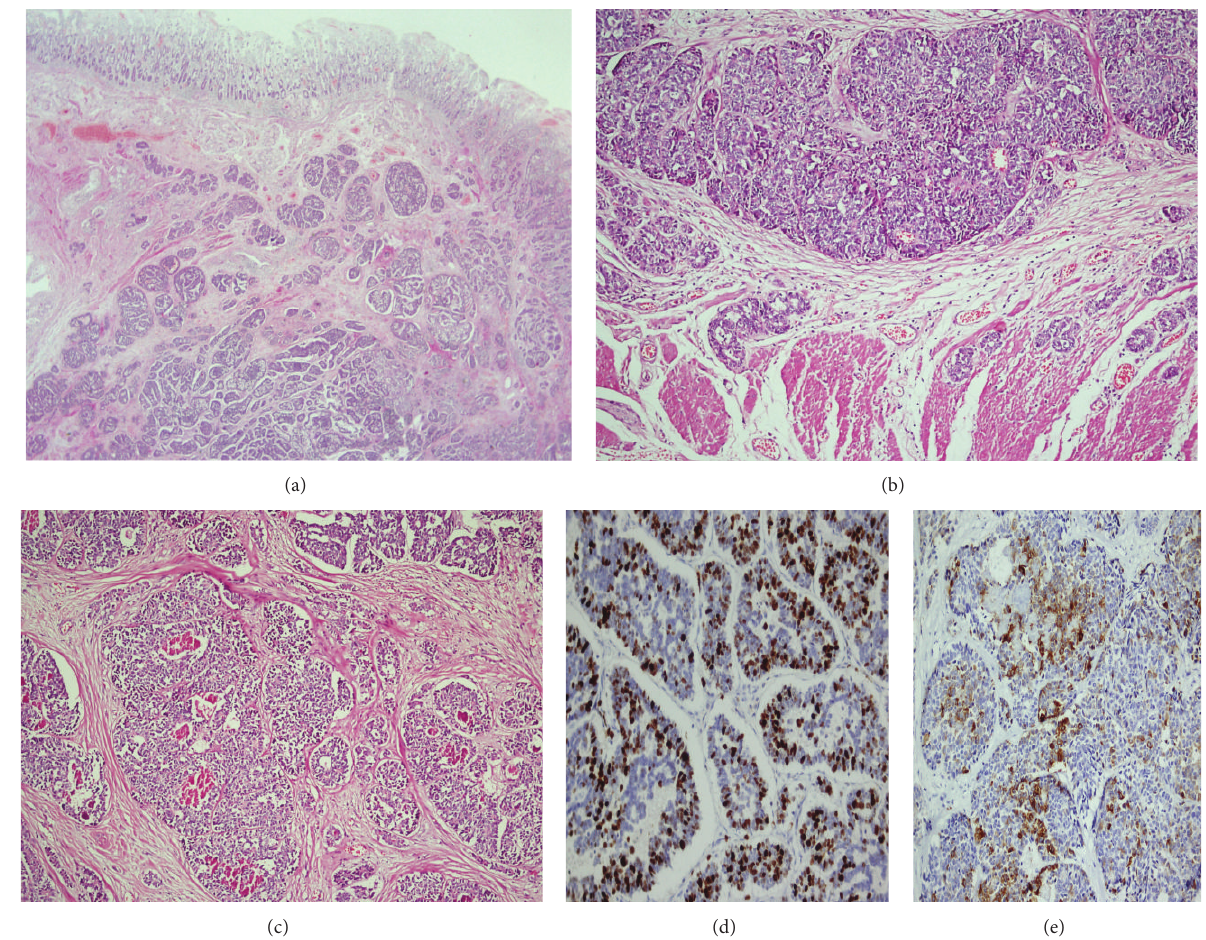
Figure1:NeuroendocrinecarcinomaofampullaofVater.(a)-(b)Neuroendocrinetumorinvadingmuscularispropriaintheampulla,(c)focal necrosis centres and moderate atypia in the tumor, (d) Ki-67 proliferation index above 20%, (e) focal positivity with